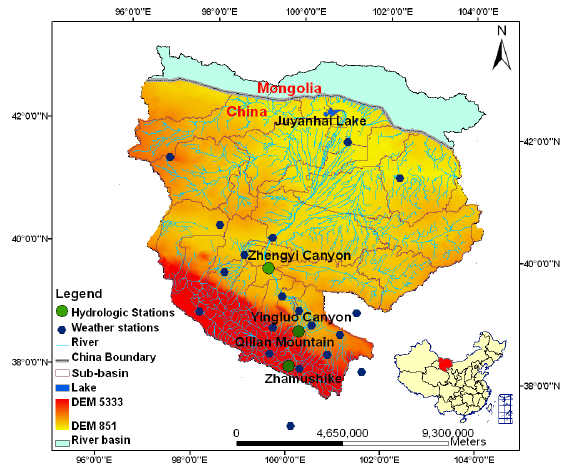
Fig. 1. The Heihe river basin with DEM, rivers, hydrological, lakes and weather stations indicated. The location of the Heihe river basin in China is shown in the